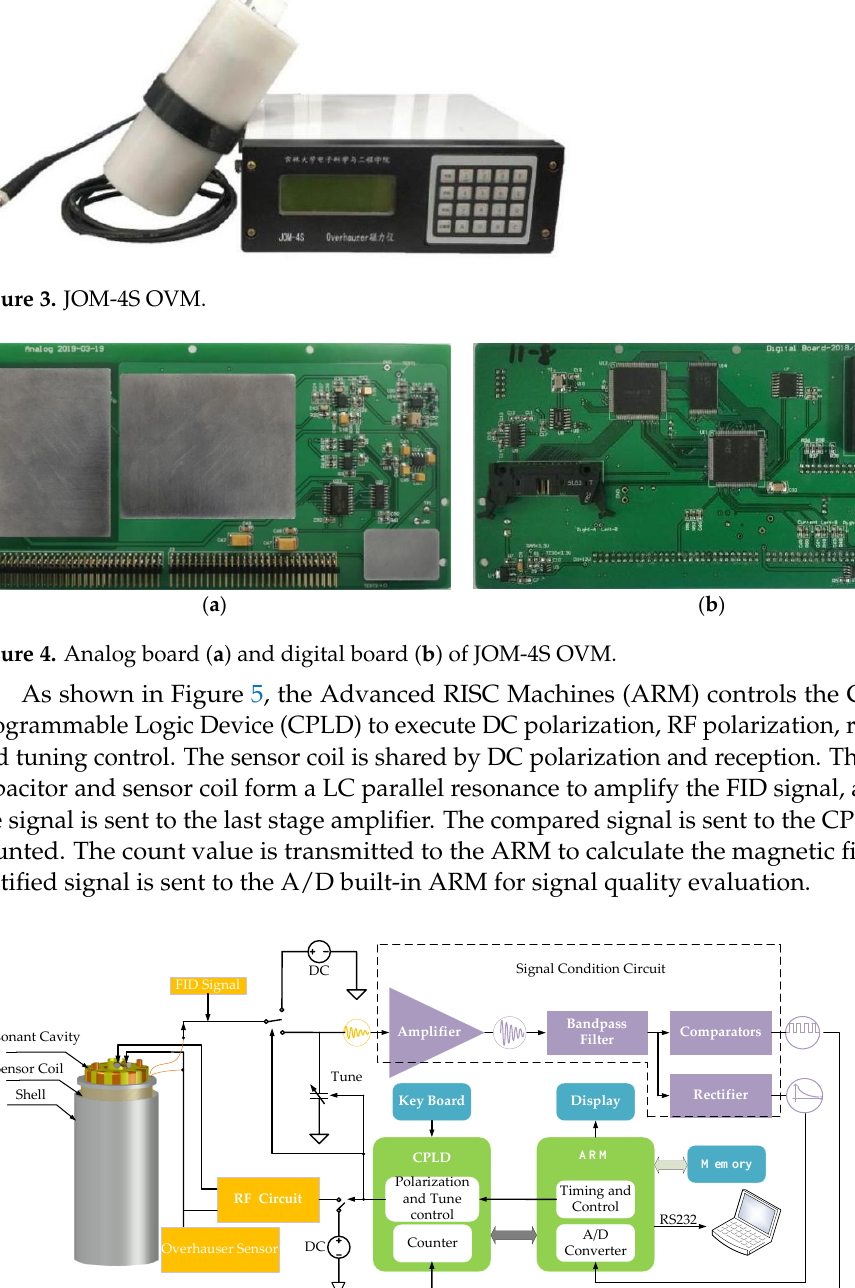
Figure 5. Block diagram of JOM-4S OVM.